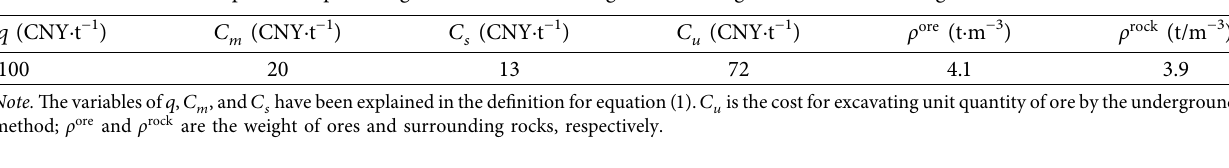
Table 3: Alternative optimal design for surface-to-underground transition in the Dagushan iron mine. Size of crown pillar (m)